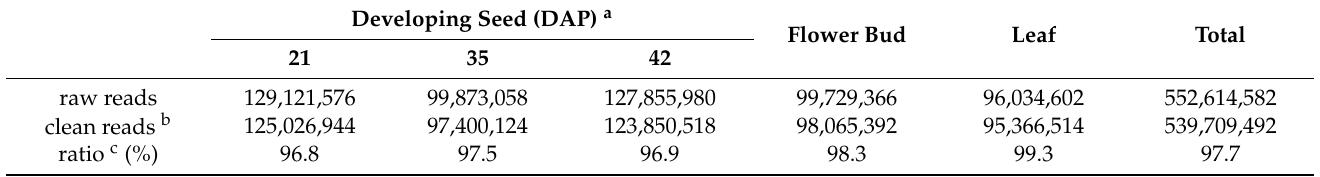
Table 1. Summary of sequencing data of P. lindheimeri seeds, flower bud and leaf transcriptomes. Developing Seed (DAP) a Flower Bud Leaf Total 21 42